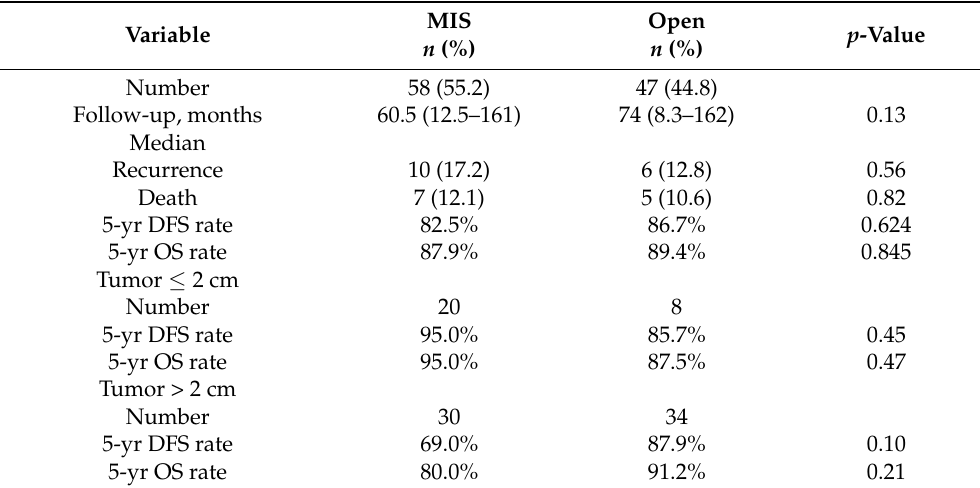
Table 2. Oncologic survival outcomes of MIS versus open radical